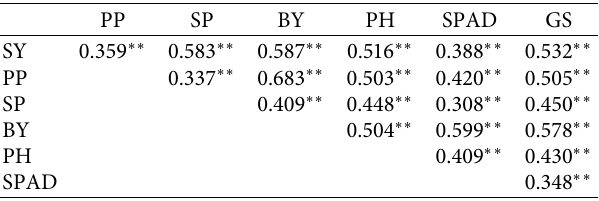
Correlation is significant at the ∗∗ 0.01 and ∗ 0.05 levels